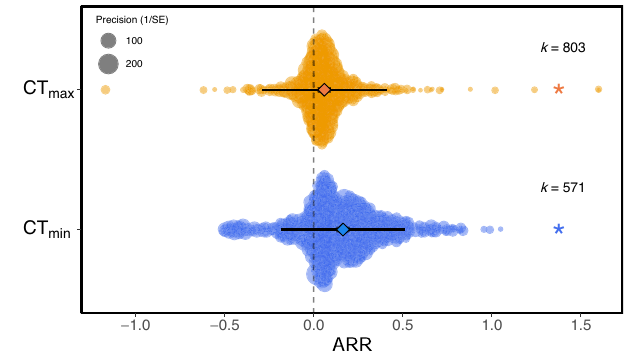
Fig. 1 | Meta-analytic mean acclimation response ratio (ARR) for upper and lowercriticalthermallimits, CT max (k=803) and CT min (k=571). A positive ARR indicates an adaptive plastic response; heat acclimation increases CT max or cold acclimation decreases CT min . 95% con fi dence intervals (95% CIs) are depicted in heavy black lines (and partially hidden by the mean data points, depicted by a diamond symbol), prediction intervals in thin black lines. The size of each data point is proportional to the precision of the study (1/SE (Standard Error)). k= number of effect sizes per group. Asterisk indicates that95% CIs do not span